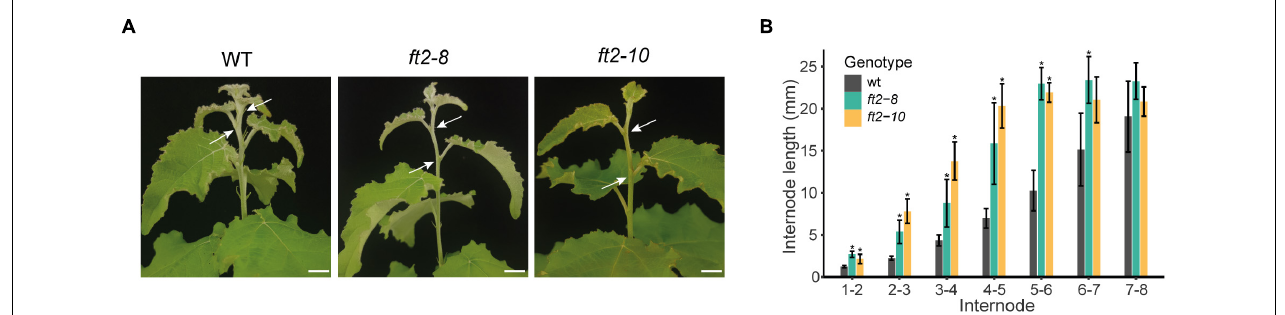
FIGURE 2 | FT2 limits internode growth in the stem elongation zone under LD conditions. (A) Images of the stem elongation zone in the WT and FT2 loss of function lines ft2-8 and ft2-10 . Arrows indicate internode 4–5. Scale bar = 1 cm. (B) Bar plot showing internode lengths in the stem elongation zone of the WT and FT2 loss of function lines ft2-8 and ft2-10 . Values represent mean internode lengths recorded in n = 5 plants. Significant differences between genotypes were assessed by Tukey’s test, * p < 0.05.